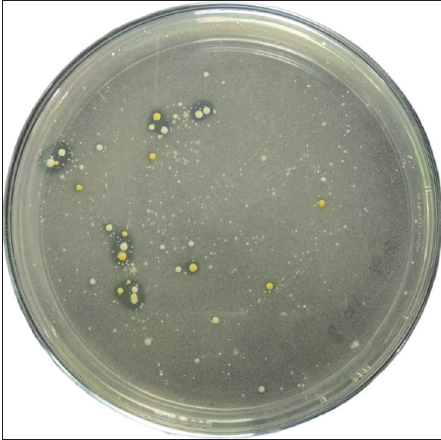
Figure-1: Lactic acid bacteria colony with clear around the Table-1: Characteristics of lactic acid bacteria colonies from rice washing water. Colony